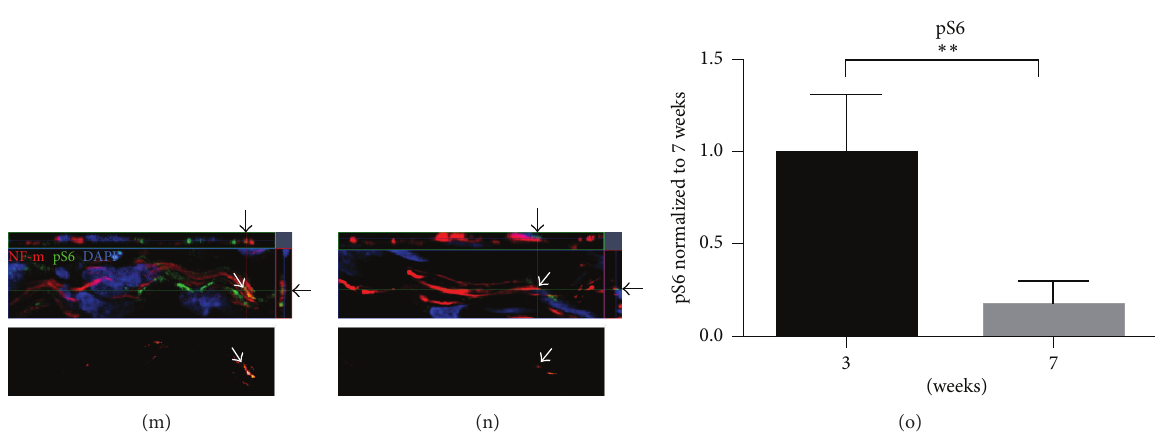
Figure 2: Intra-axonal PSM is downregulated when axonal growth “stalls.” Representative confocal images from ascending CNS axons immunolabeled for NF-m (red) in PNGs at 3 weeks (a, d, g, h, and m) and 7 weeks (b, e, h, k, and n). The image sets colabeled for 4EBP1 (a, b), p4EBP1 (d, e), eIF2 𝛼 (g, h), peIF2 𝛼 (j, k), and pS6 (m, n) are shown. Top panel of each image set represents exposure matched orthogonal projections showing XY , XZ , and YZ planes indicating axon-specific signal (arrows). Bottom panel of each image set shows the subtracted image with axon-only signal (see Section 2.4 for details) for each specific protein as indicated by an intensity spectrum. These projections were generated from 8 to 10 optical sections with 0.3 𝜇 m z-step intervals. Scale bar = 5 𝜇 m. Graphs (c), (f), (i), (l), and (o) show quantification of relative immunolabeling intensity for the subtracted axon-only signals for 4EBP1, p4EBP1, eIF2 𝛼 , peIF2 𝛼 , and pS6, respectively. Data are expressed as fold change in signal intensity compared with 3-week grafts ± SD. ∗ 𝑝 ≤ 0.05 , ∗∗ 𝑝 ≤ 0.01 , and ∗∗∗∗ 𝑝 ≤ 0.001 , using Holm-ˇS´ıd´ak post hoc